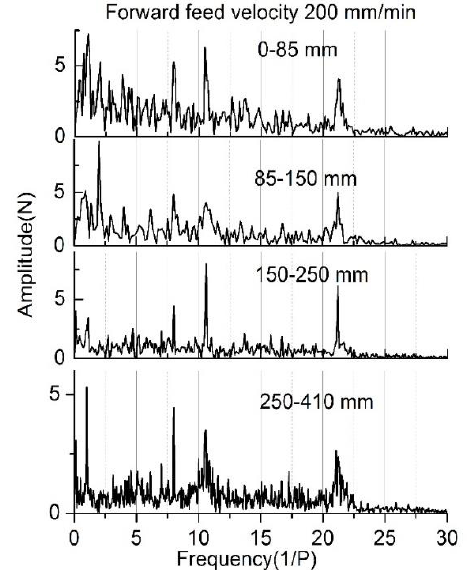
Figure 17. Amplitudes of FFT components for different segments.